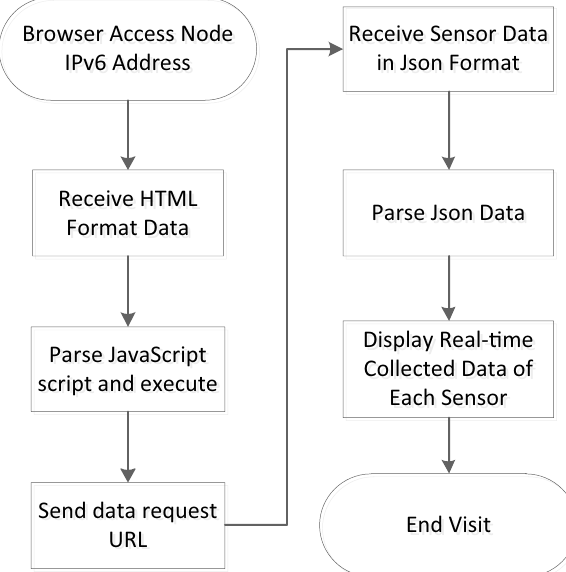
Figure 11. Workflow of the browser connection.